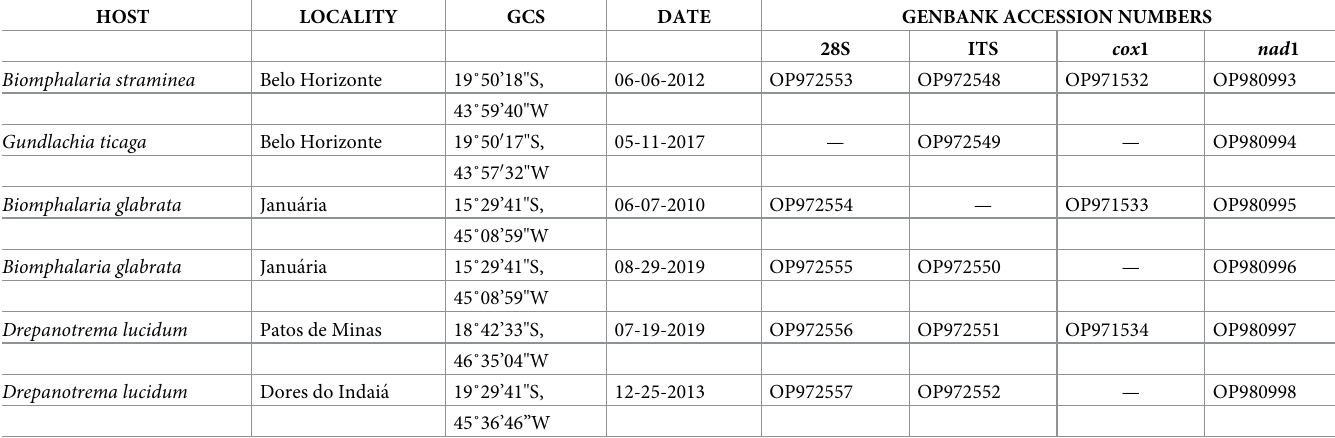
Table 1. Data on the studied cercarial samples collected from planorbid snails in the state of Minas Gerais, Brazil.